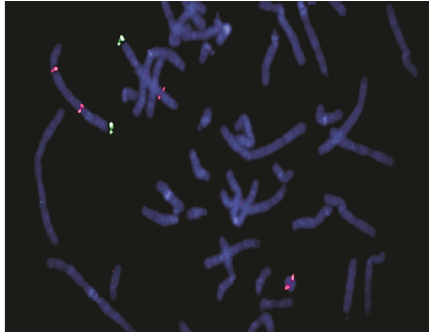
Figure 4: Red signal = RP11-158016 4q13.1 (also hybridizes to 4q31); green signal = 4 pter.